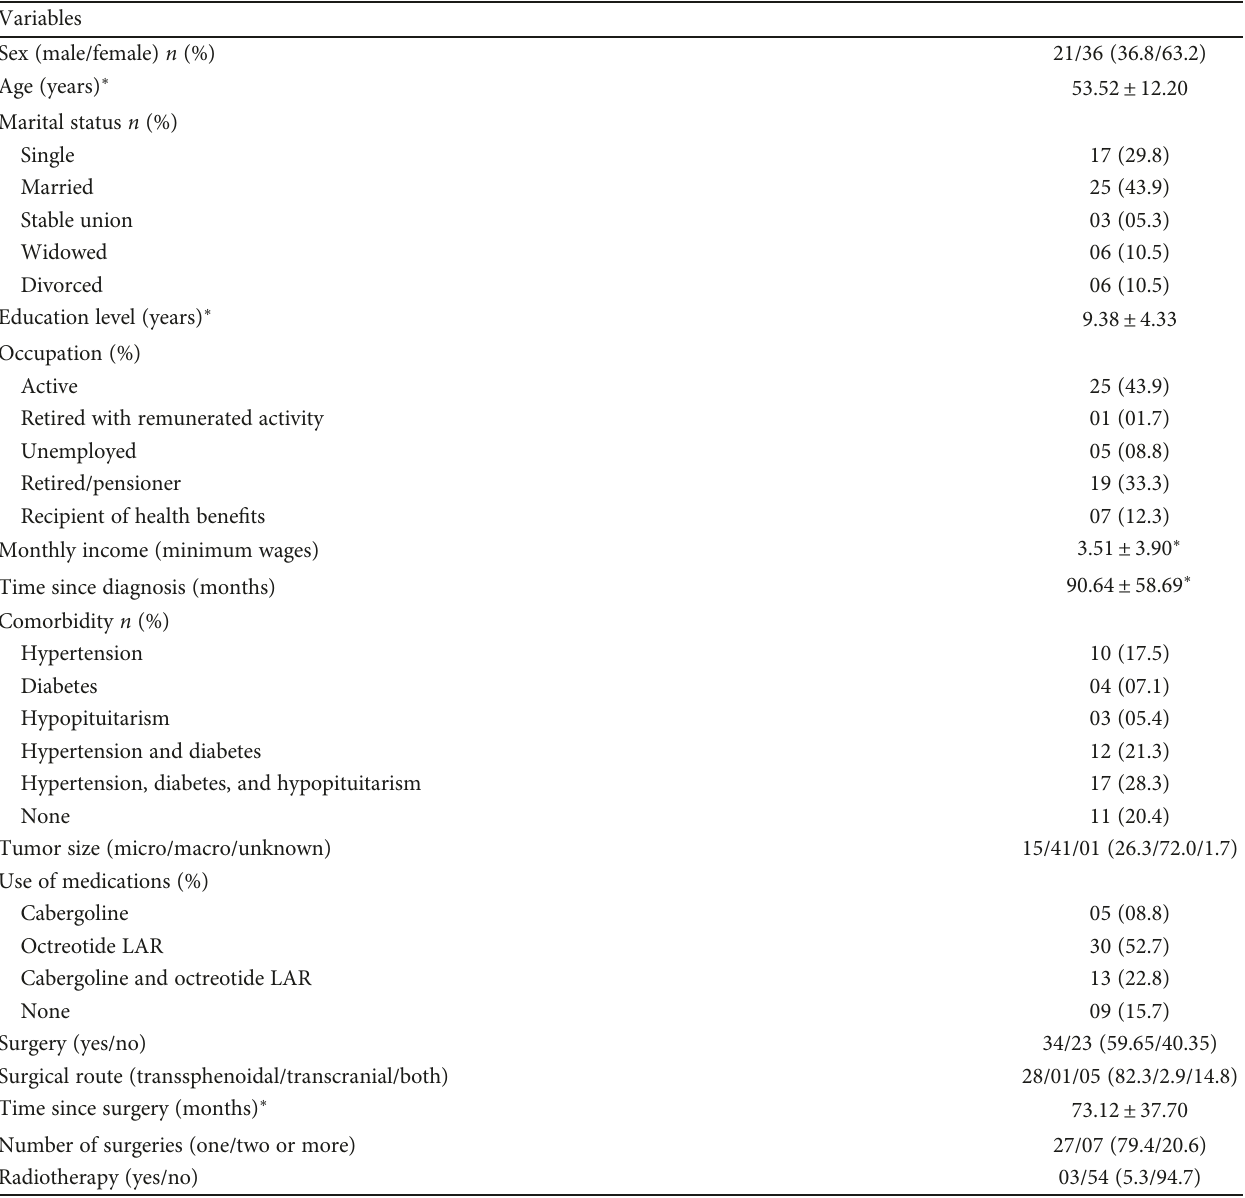
Table 1: Socioeconomic variables, diagnosis, comorbidities, and treatment of patients with acromegaly, São Luís, state of Maranhão, Brazil, 2015.